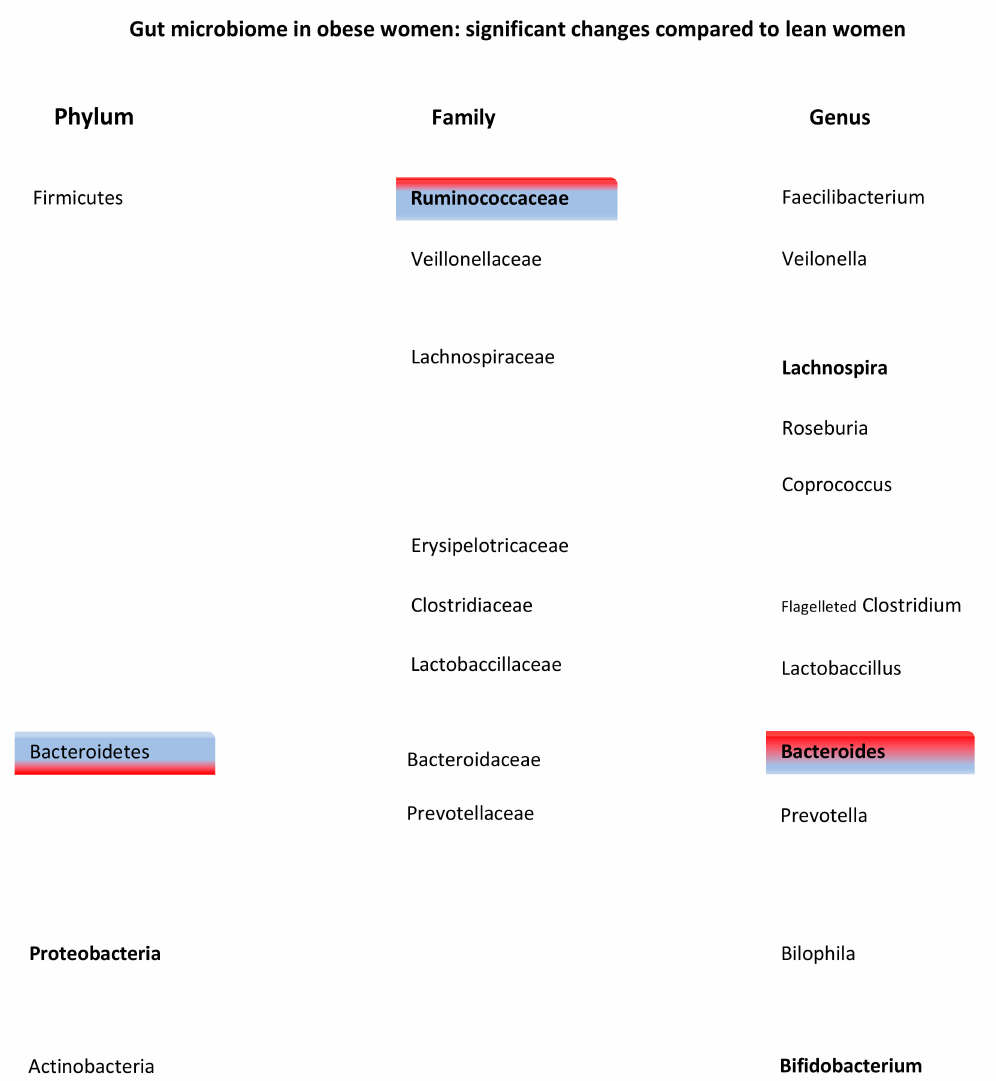
Figure 3. Changes in microbes of the gut microbiome in obese women compared to lean women. Phyla are divided in families and genera. Red corresponds with an increase and blue with a decrease in relative abundance of the phylum, family or genus in obese women. No color represents that this phylum or family was not specifically mentioned in the literature. When text font is bold, more that one article has found this